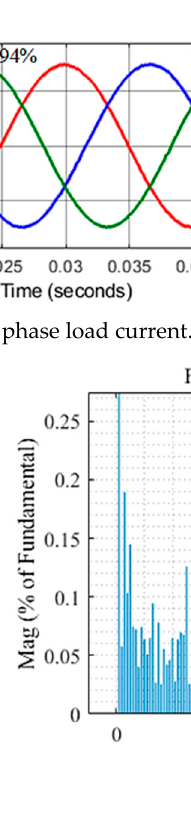
Figure 9. Effect of weighting coefficient on THD and 𝛥𝑉 (cid:3031)(cid:3030) characteristics. Steady-state responses at reference current 3 A of the improved method for the asym- metric T-type NPC inverter are illustrated in Figure 10. Load currents are sinusoidal and stable at the set values with THD about 0.94%, as in Figure 10a,c. The capacitor voltages ∆ V dc are maintenance balanced with Δ V about 4 V, as shown in Figure 10b.